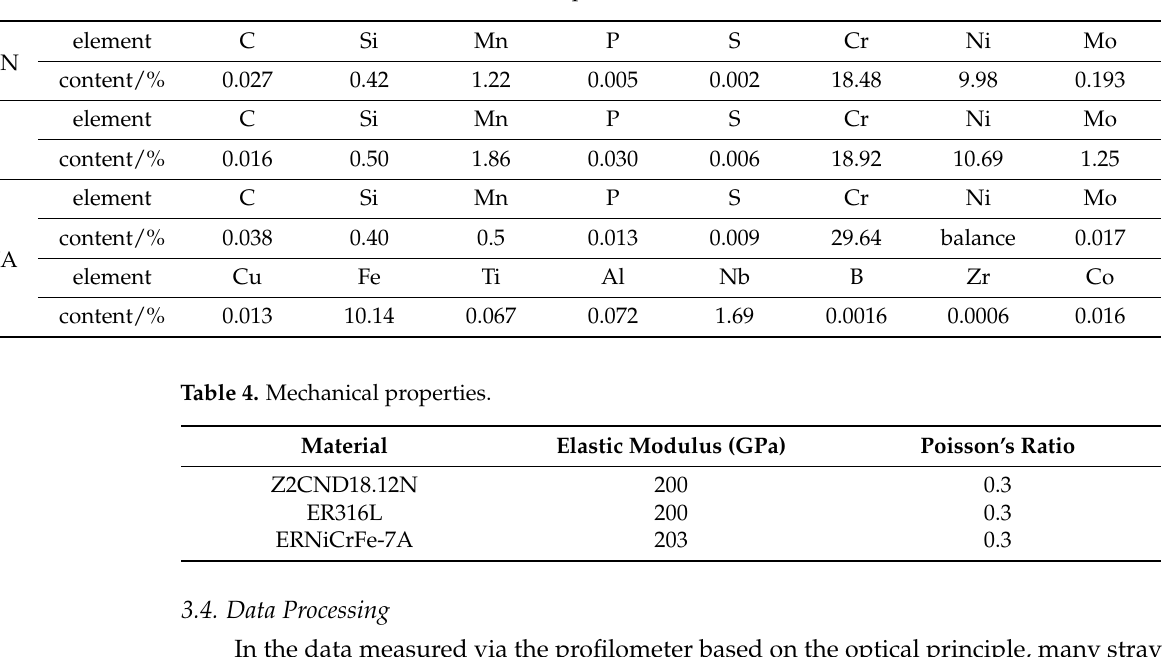
Figure 5. Models of stress calculation. Table 3. Chemical compositions.